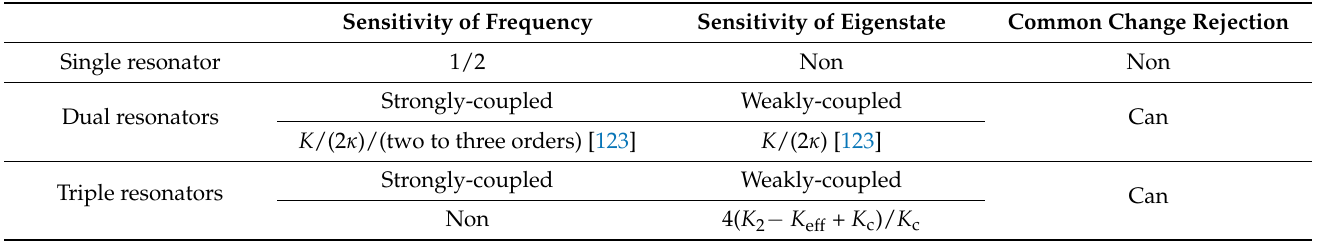
Table 1. Properties of single resonator, dual and triple resonators.